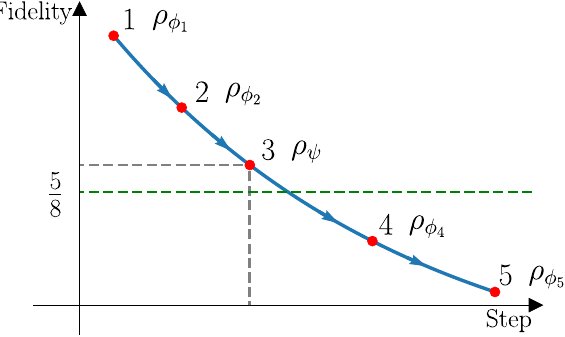
Fig. 3 Illustration of reverse revolution. At point 3, the state preparation is accomplished; At point 4 and point 5, the system is under reverse evolution. In the perfect case, the state can return back to Bell pairs and Néel state. Here, due to the noise and , and decoherence, we denote the corresponding mixed state as ρ ϕ i Φ the fi delity is Tr ð ρ ϕ i Þ to the perfect case. Note that one can i estimate the fi delity to Φ 1 , Φ 5 with one measurement settings Z ⊗ 10 , and the one to Φ 2 , Φ 4 with two settings X ⊗ 10 , Z ⊗ 10